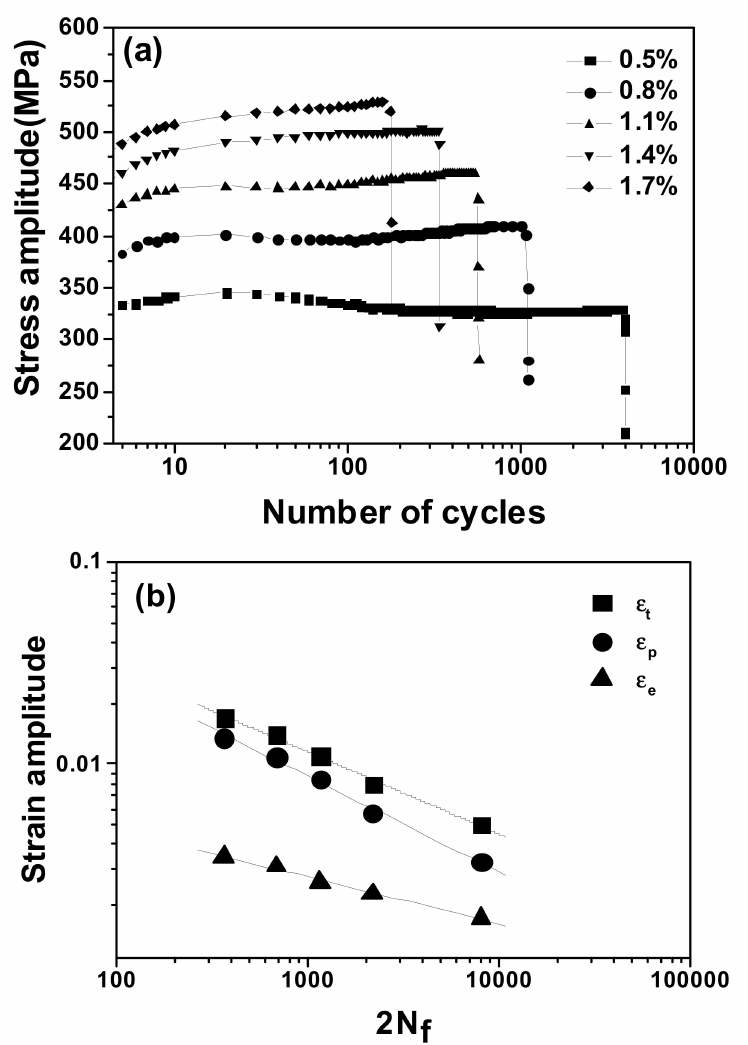
Figure 2. Low-cycle fatigue behavior of austenitic 316 stainless steel: ( a ) cyclic stress response curves under various strain amplitudes and ( b ) Basquin and Coffin-Manson plot. Cyclic hardening was observed in the initial cycles within several tens of cycles and was followed by slight second